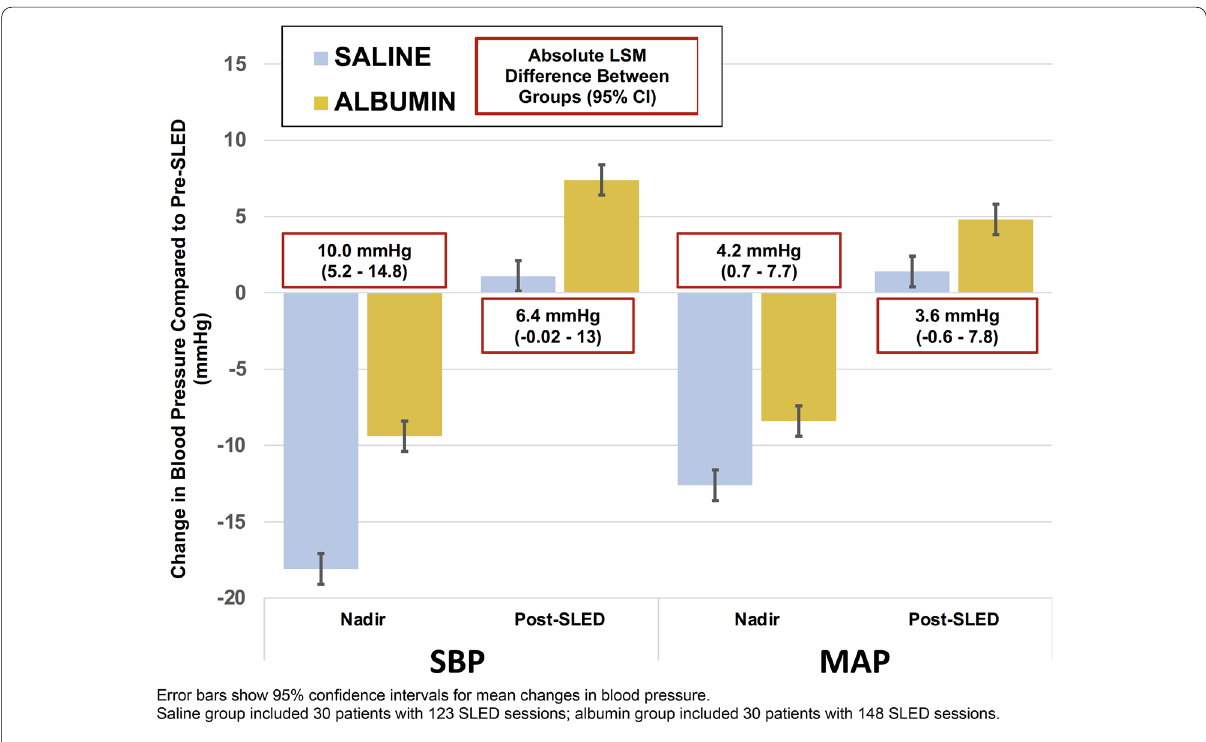
Fig. 2 Unadjusted mean blood pressure changes (intra‑SLED nadir and post‑SLED compared to pre‑SLED), and the modeled absolute difference between saline and albumin groups. Error bars show 95% confidence intervals for mean changes in blood pressure. Saline group included 30 patients with 123 SLED sessions; albumin group included 30 patients with 148 SLED sessions. SLED: sustained low‑efficiency dialysis; LSM: least square mean; SBP: systolic blood pressure; MAP: mean arterial